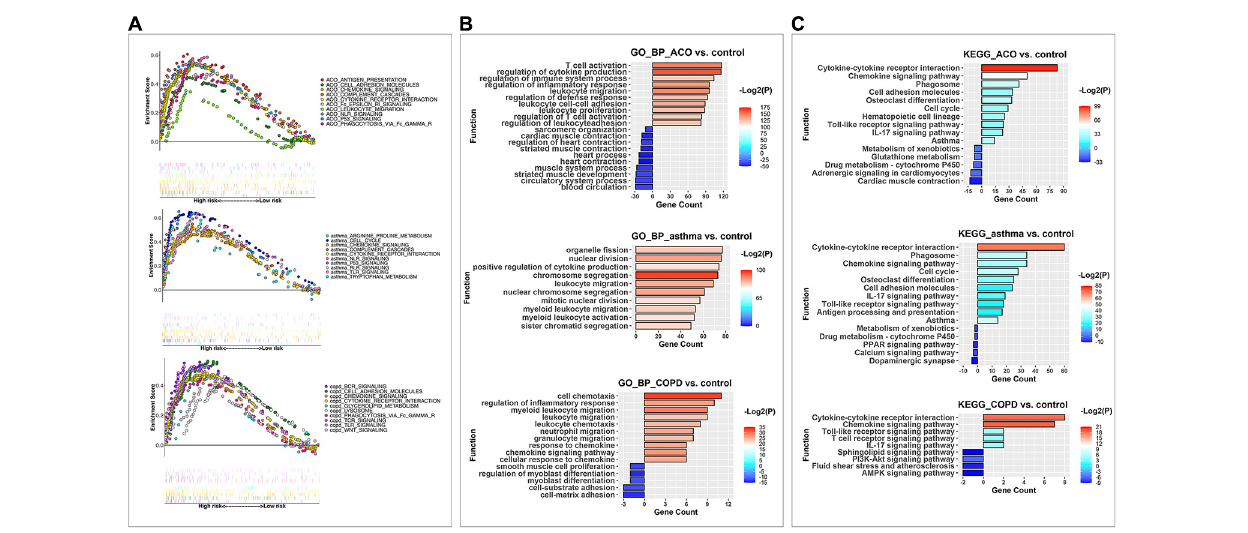
FIGURE 4 | GSEA, KEGG, and GO analysis were used to analyze the key pathways of DEGs in different models. (A) the enriched KEGG pathways in each model after GSEA analysis. Each point represented a gene; the scattered points in upward trend indicated positive contributions to the enrichment of this item, and that in downward trend demonstrated negative contributions. Each vertical line represented the gene that contributes to this item. Different colors represented different items, and the straight line connected end to end expressed the same gene in additional items. (B) the enriched upregulated and downregulated biological process items using GO BP analysis. (C) the enriched upregulated and downregulated pathways by KEGG